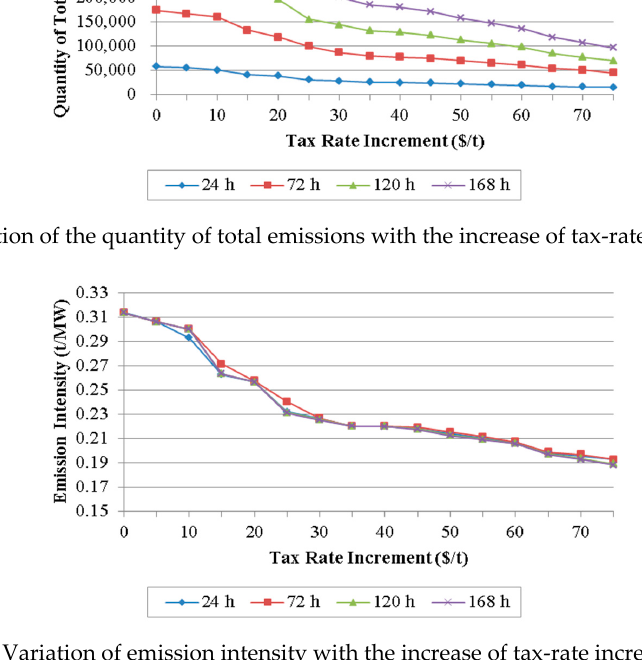
Figure 3. Variations of total generation profits, total generation level, the quantity of total emissions, and emission intensity with the increase of tax-rate